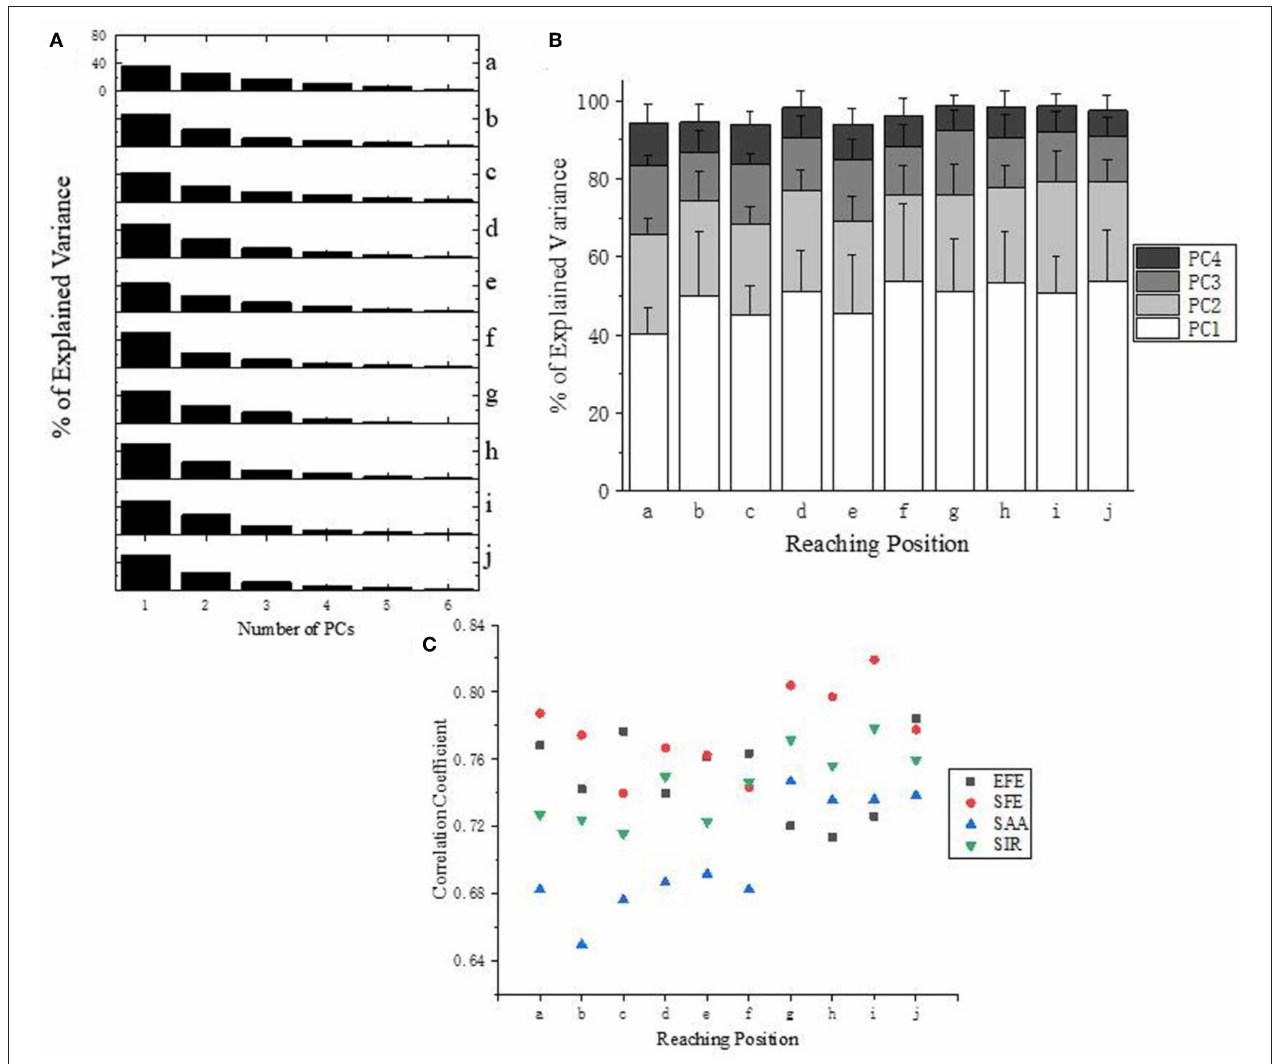
FIGURE 6 | (A) Explained Variance for all target positions (a–j) of subject 10. (B) Explained Variance of first four PCs at all reaching position across all subjects. (C) Correlation analysis of the first PC (synergy 1) across subjects according to different